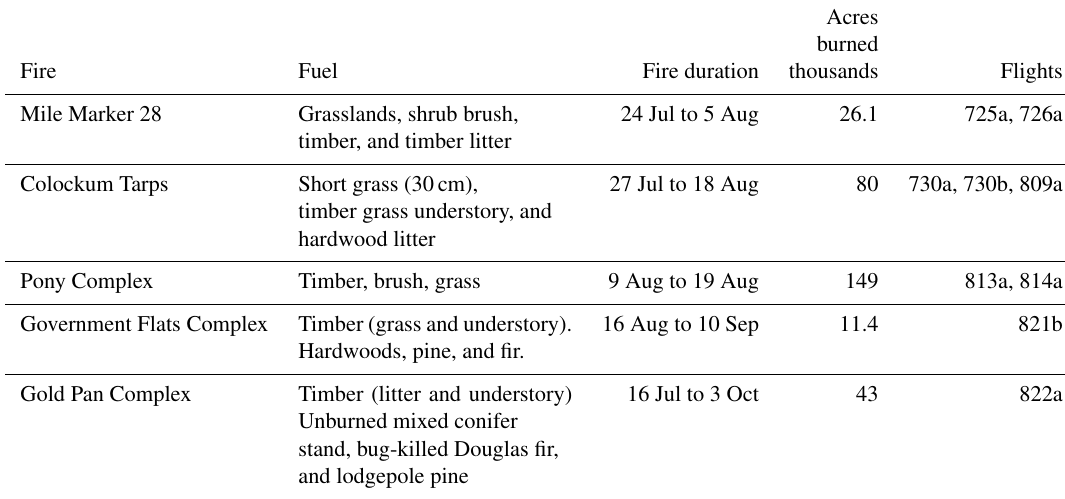
Table 3. Wildfires used for time evolution study.